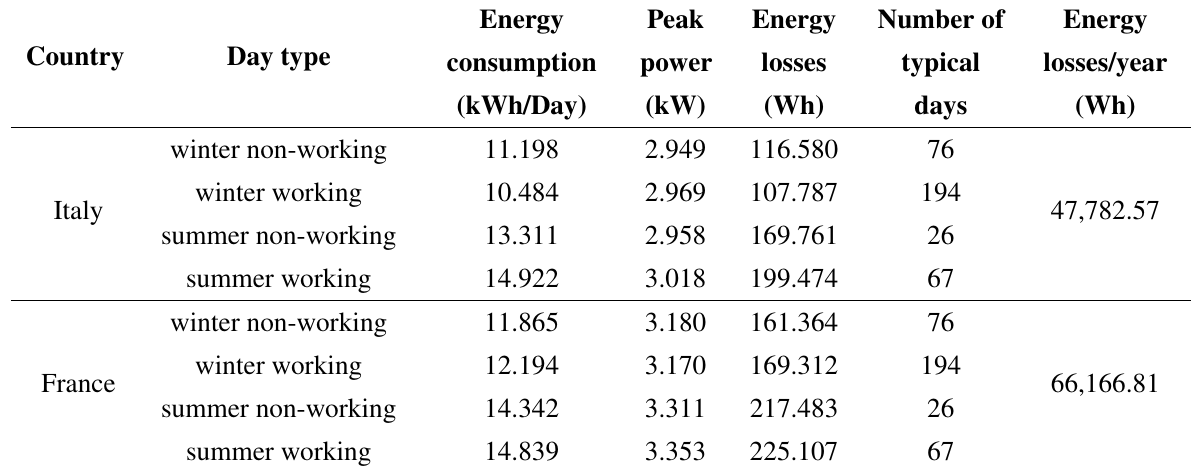
Table 3. House energy losses per country-scenario